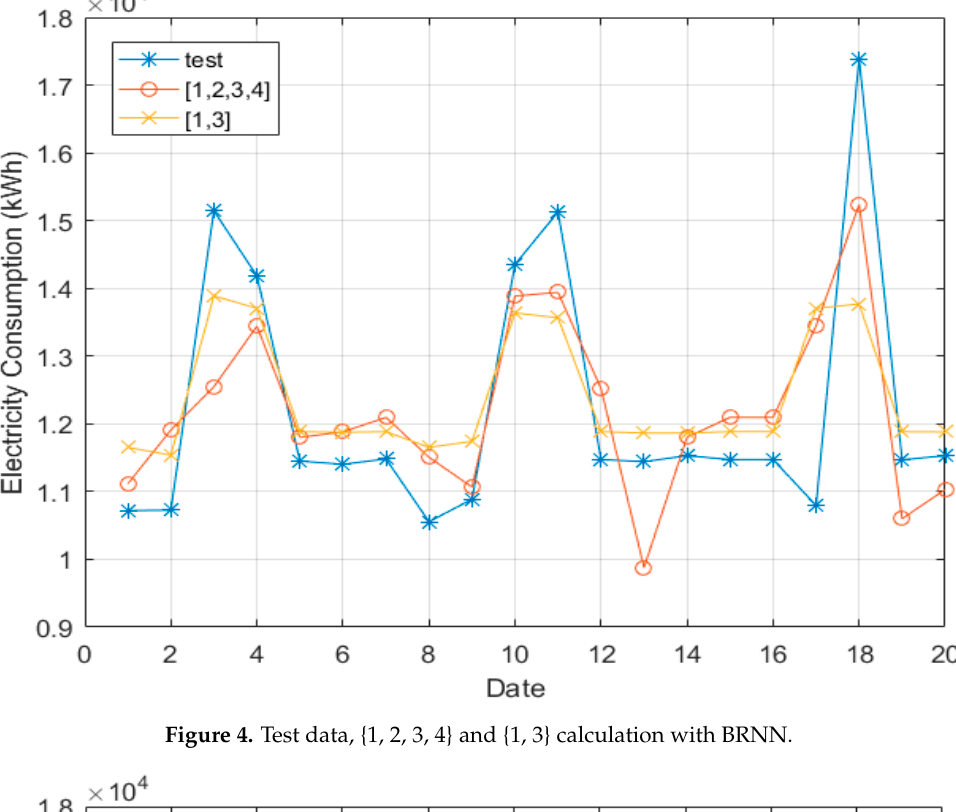
Figure 4. Test data, {1, 2, 3, 4} and {1, 3} calculation with BRNN.